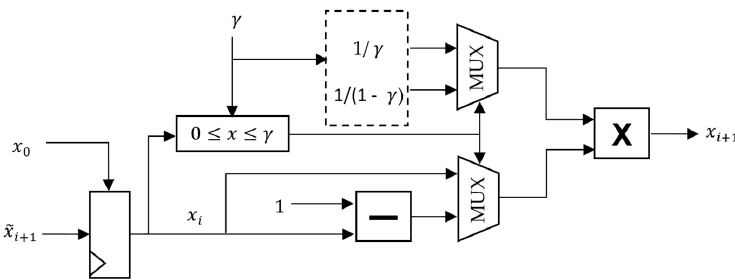
Figure 4. Block diagram of the proposed 64-bit Skew Tent Map generator. Values 1/(cid:2011) and 1/(1 − (cid:2011)) are precalculated when initializing the chaotic cipher and they are constants for the whole